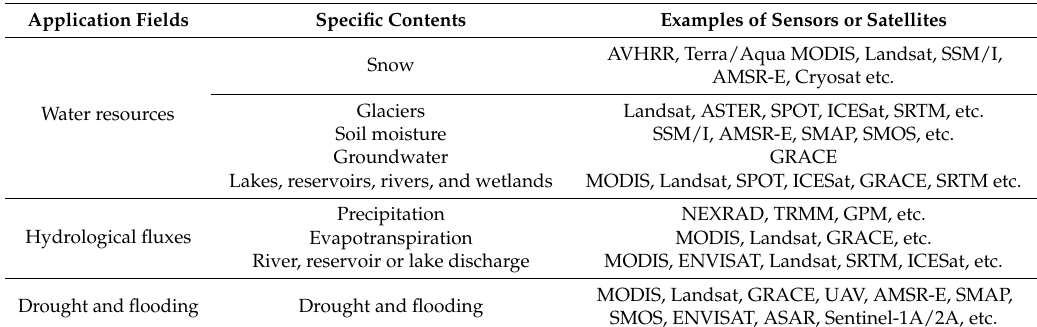
Table 1. Latest remote sensing technology and sensors used for water resources, hydrological fluxes, drought and flood